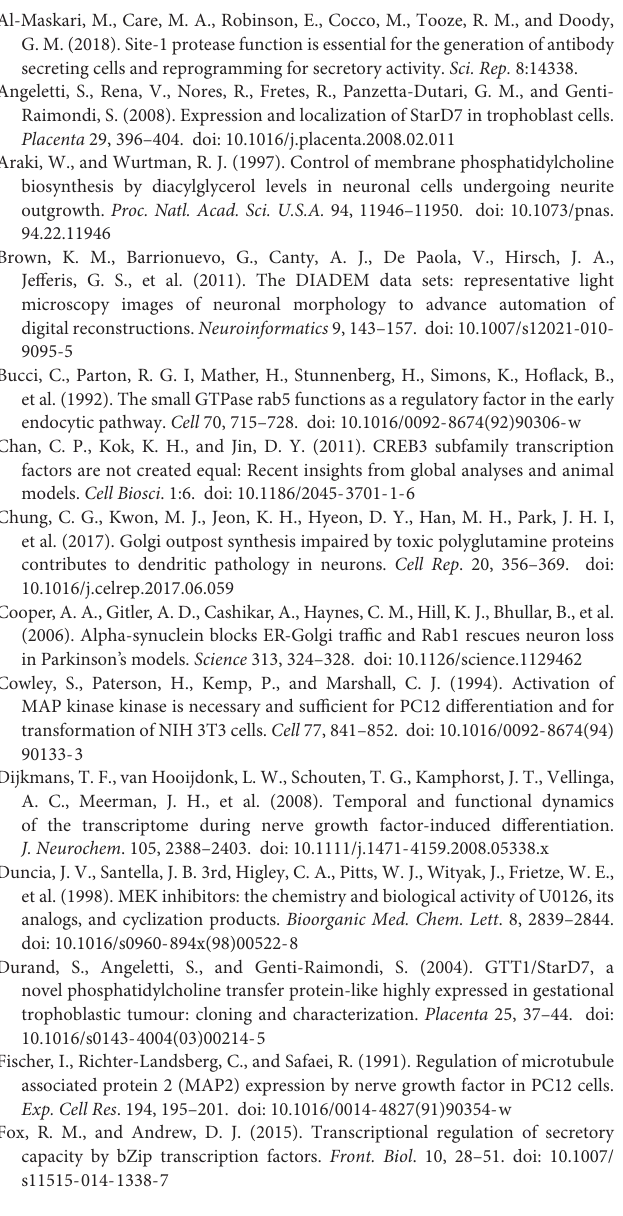
Supplementary Figure 3 | Gain- and loss-of functions of both Rab1b and Rab5, proteins associated with membrane trafficking pathway, alter the neuronal differentiation of PC12 cells. (A) Representative images of differentiated PC12 cells transfected with control EGFP, Rab1b WT-EGFP, or Rab1b N121I-EGFP plasmids and fixed at 4 days post NGF induction. Insets show Rab1b distribution in the cell soma. Quantification of the total neurite length (B) and the longest neurite (C) . (D) Representative images of differentiated PC12 cells transfected with control EGFP, Rab5 WT-EGFP, or Rab5 S34N-EGFP plasmids and fixed at 4 days post NGF induction. Quantification of the total neurite length (E) and the longest neurite (F) . Bars represent the mean ± SEM of three independent experiments carried out in triplicates, and a total of 40 cells were analyzed. Statistical data analysis was performed, using Student’s T -test, considering statistically significant a value of p < 0.05 ( ∗ p < 0.05, ∗∗ p < 0.01; ∗∗∗ p < 0.001).